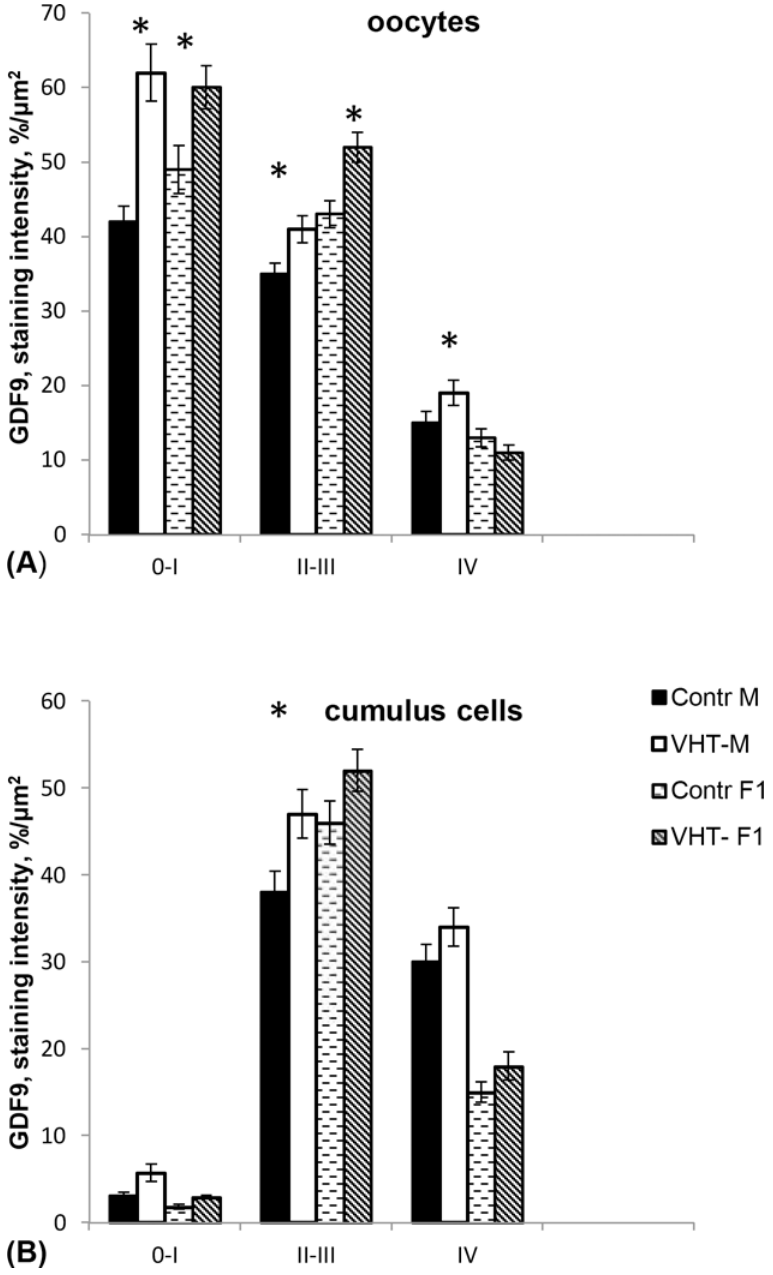
Fig 6. The dynamic of GDF9 protein expression in the oocytes and cumulus cells of the follicles at different stages of the development in rabbits ovaries. Control M – mothers generation (n = 7); Control F1- female offspring born to the control mothers (n = 7); VHT-M- VemoHerb-T treated mothers (n = 7); VHT-F1- female offspring born to the treated mothers (n = 7); 0-I – primordial and primary follicles; II-III – secondary and preantral follicles; IV – antral follicles. * — significant differences, p < 0.05. Protein expression was estimated by the program ImageJ based on the intensity of immunostaining reactions on the defined square. At least 5 slides per animal were analysed. Significantly intensive signals were detected in the oocytes from primordial, primary and secondary follicles in the ovaries of threated mothers as well as in the oocytes from secondary follicles of F1 females born to the treated